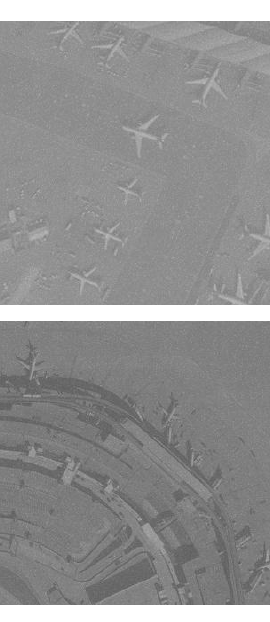
Figure 5. Examples of image slices from the dataset. Slices contain aircrafts and airport complex backgrounds.